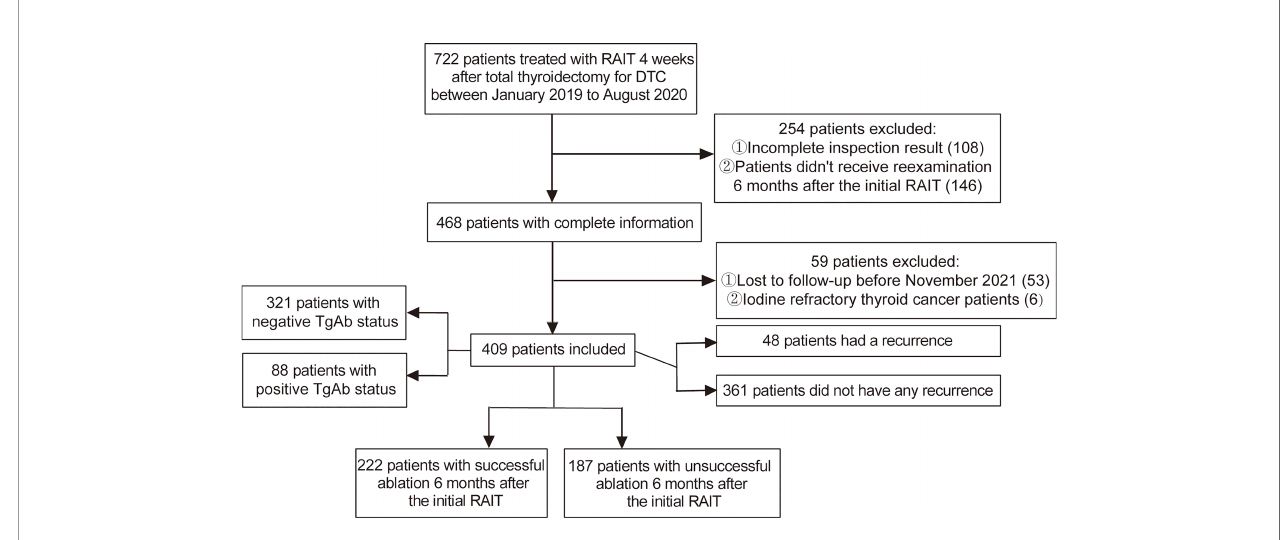
FIGURE 1 | Flowchart of patient inclusion in the